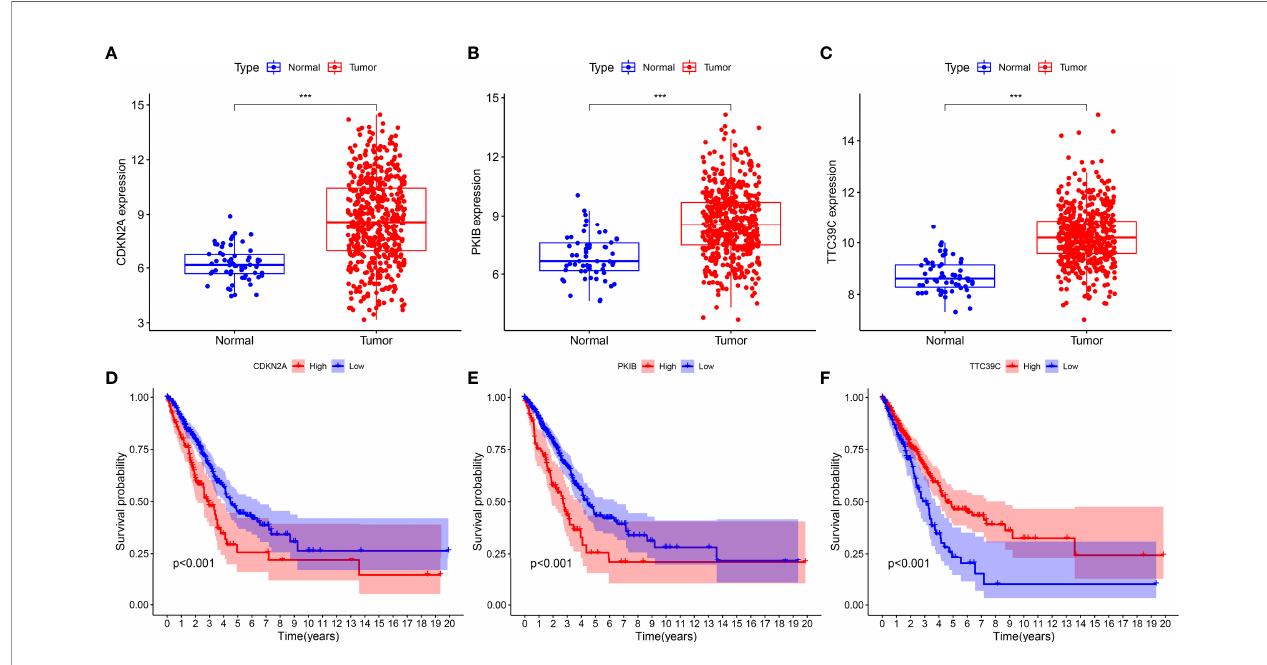
FIGURE 7 | Identi fi cation of prognostic AS events-related genes. (A – C) The expression patterns of CDKN2A, PKIB, and TTC39C in LUAD and normal tissues. (D – F) Kaplan-Meier plots of different expression of CDKN2A, PKIB, and TTC39C. ***p <